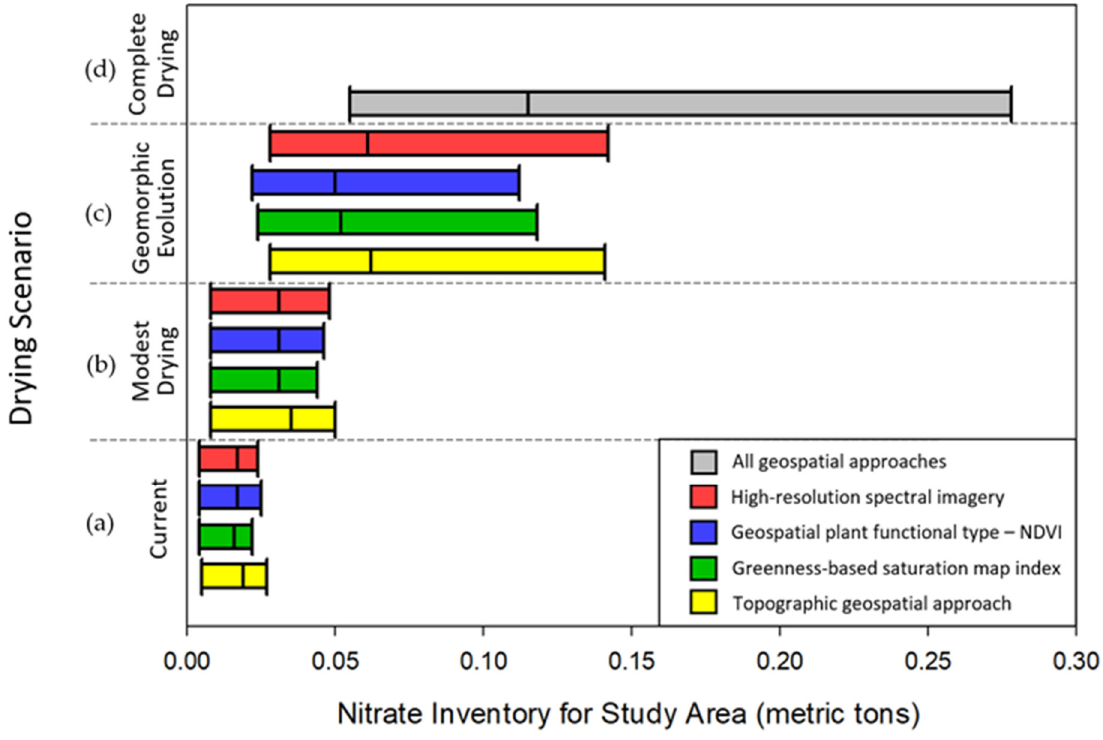
Figure 4. Study site NO 3 − inventories based on current inventory ( a ) and possible future inventories resulting from our three drying scenarios: ( b ) modest drying with active layer deepening, ( c ) geo- morphic evolution of polygonal features, and ( d ) complete drying. Each whisker represents the 25%, 50%, and 75% statistical quantile distributions utilized to calculate these inventories. The colors of the whiskers represent the four geospatial approaches estimates, where grey is used for the complete drying scenario as all geospatial outcomes are the same for this scenario.